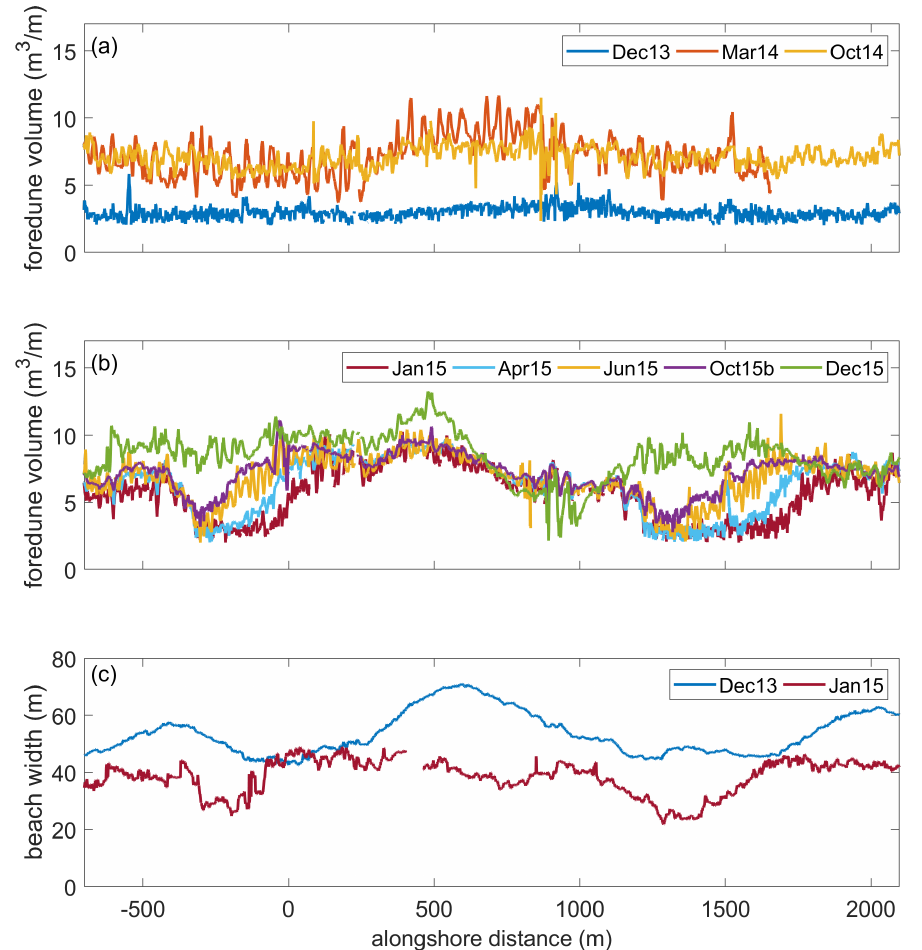
Figure 10. ( a ) Volume between the 3 and 5 m contour line as a function of the alongshore coordinate for the Dec13, Mar14 and Oct14 surveys ( b ) same as ( a ) but then for Jan15, Apr15, Jun15, Oct15b and Dec15 surveys, ( c ) width of the upper beach for Dec13 and Jan15